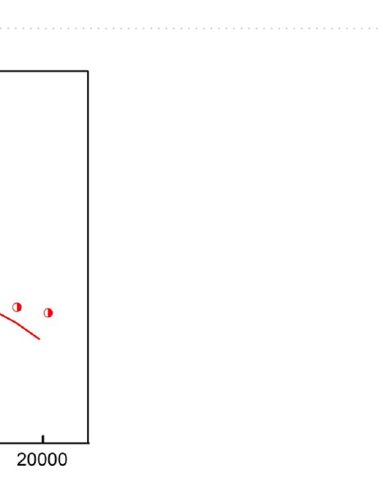
Figure 5. Nyquist diagrams for tested titanium alloy samples under various test conditions: ( a ) Ti-6Al-4V and ( b ) Ti-6Al-4V-0.11Ru.